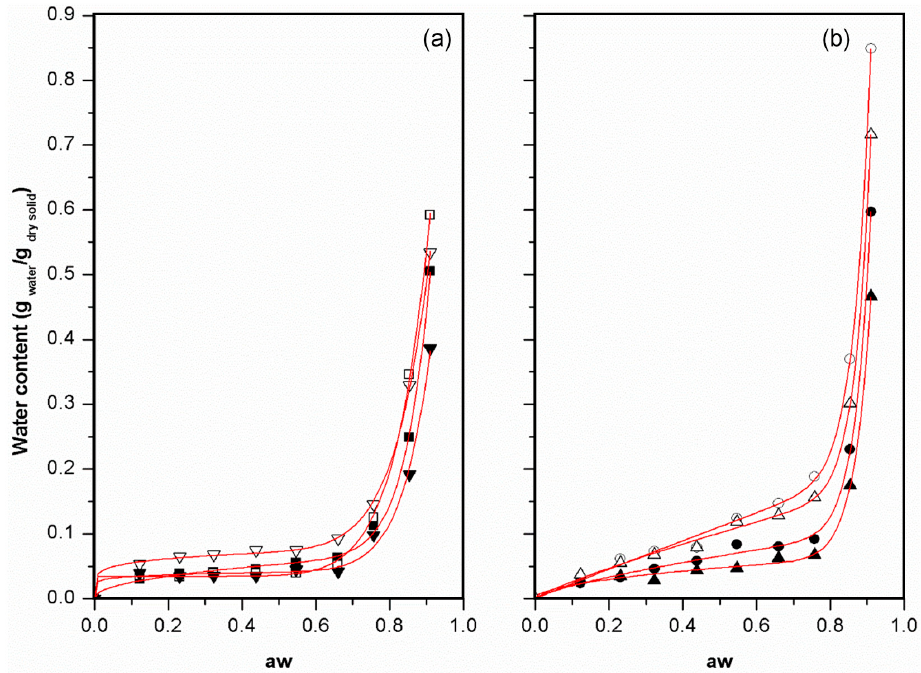
Figure 4. Equilibrium moisture sorption isotherms of selected films fitted to Peleg model: ( a ) Chitosan (C) based films: C-L10 and C-L25 (crosslinked chitosan-based films without olive oil); C-L10O25 and C-L25O25 (crosslinked chitosan-based emulsion films); ( b ) Alginate (A) based films: A- L10 and A-L25 (crosslinked alginate-based films without olive oil); A-L10O100 and A-L25O100 (crosslinked alginate-based emulsion films). Films contain different contents of soybean lecithin (L, % w/w lipid basis) and olive oil (O, % w/w polymer basis). Peleg model was fitted to water vapour sorption data. The high determination coefficient (>0.986), low value of mean relative error (4.2–8.0%) and standard deviation